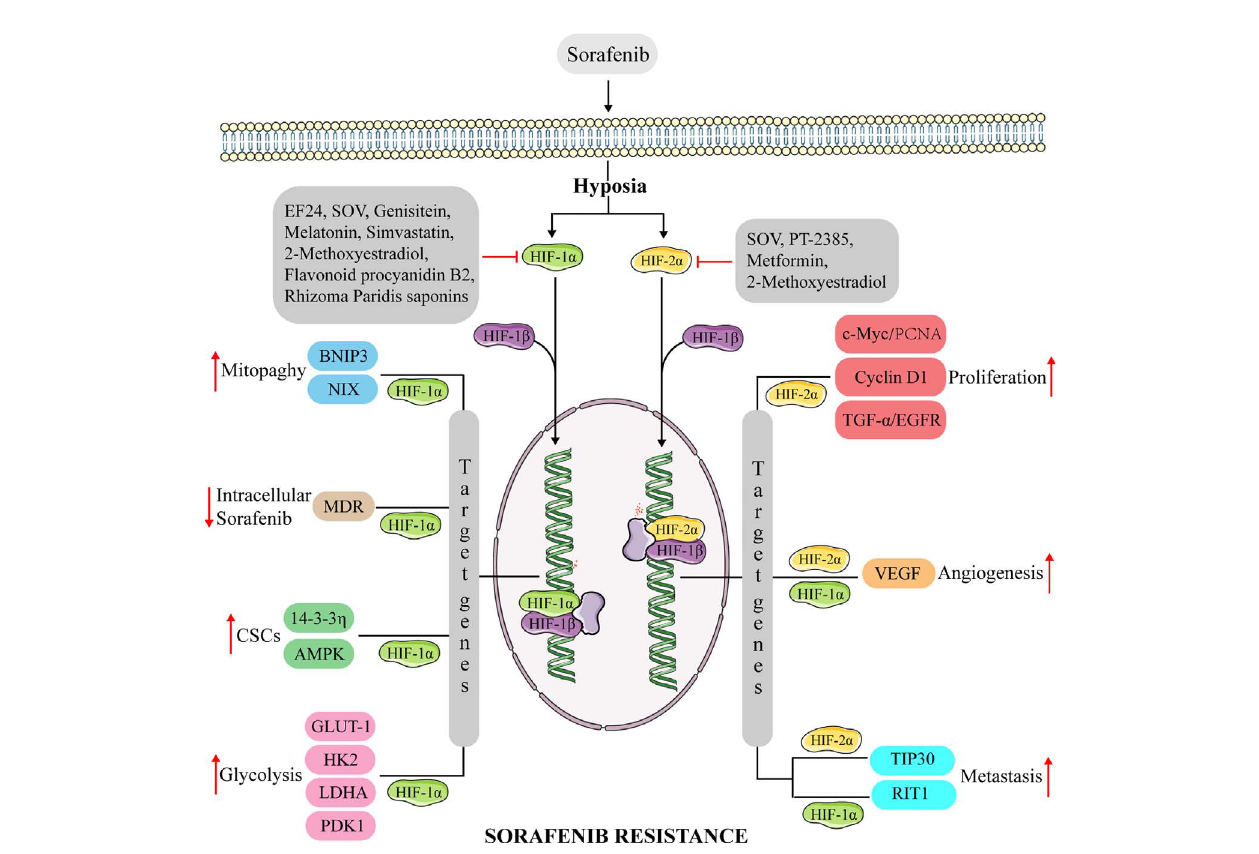
FIGURE 2 | The mechanism of anti-HIFs overcoming sorafenib resistance in hepatocellular carcinoma. Continuous sorafenib treatment induce the dysregulation of HIF-1 a and HIF-2 a expression in hepatocellular carcinoma, promoting the transcription of multiple genes involved in proliferation, CSCs, metastasis, glycolysis, mitophagy, and angiogenesis. Causes hepatocellular carcinoma to develop resistance to sorafenib. Anti-HIFs could overcome this drug resistance. BNIP3, adenovirus E1B 19kDa-interacting protein 3; NIX, BNIP3-like protein X; MDR, multidrug resistance protein; AMPK, AMP-activated protein kinase; GULT-1, glucose transporter 1; HK2, hexokinase 2; LDHA, lactate dehydrogenase A; PDK1, pyruvate dehydrogenase kinase isoform 1; c-Myc, Myc proto-oncogene protein; TGF- a , transforming growth factor a ; RIT1, Ras like without CAAX